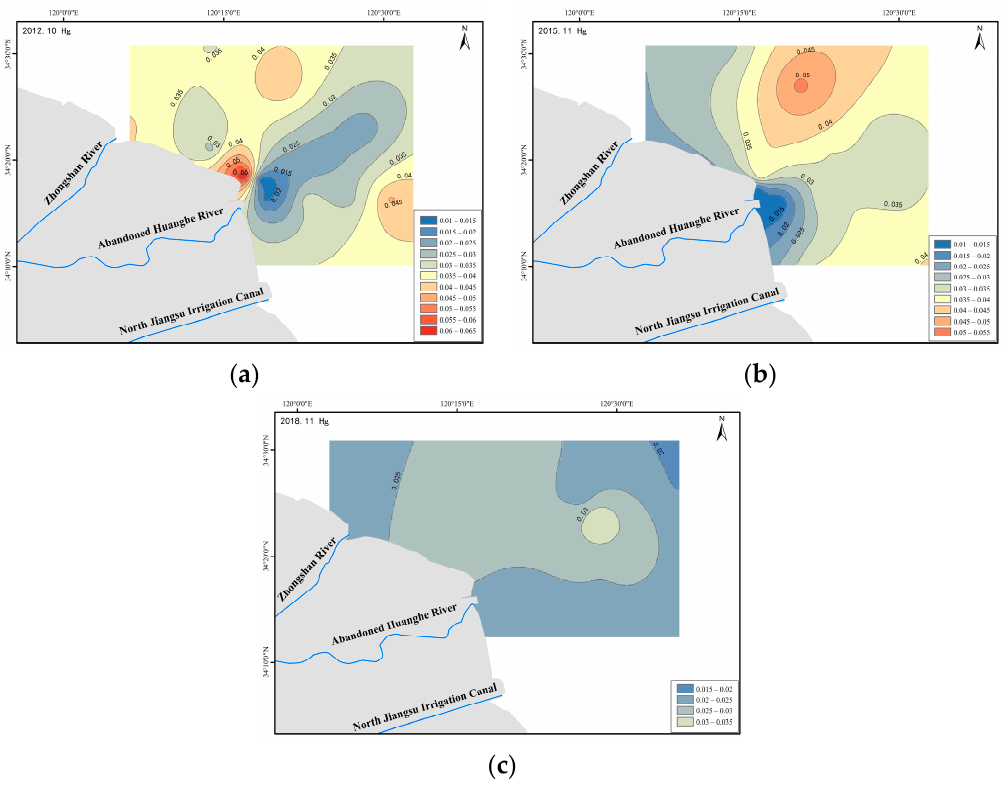
Figure 10. Spatial distribution of Hg in the sediments. ( a ) 2012; ( b ) 2015; ( c ) 2018.